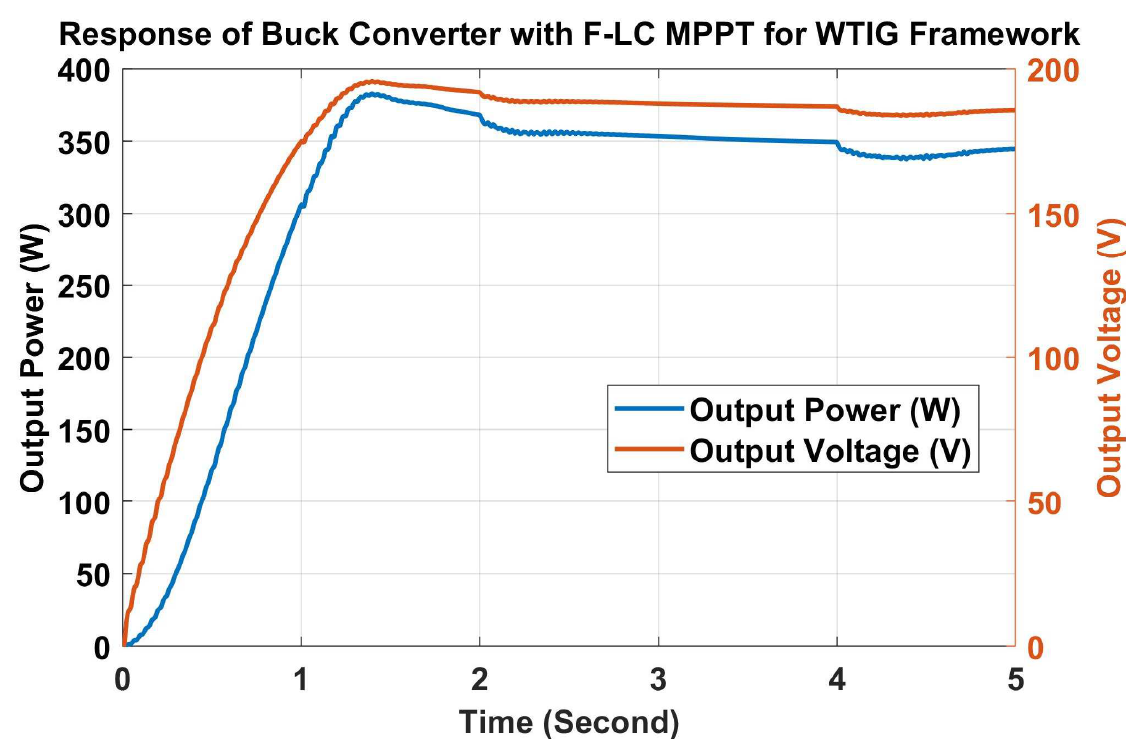
Figure 19. Output Power and Voltage of Power Buck Converter with F-LC MPPT for WTIG Framework.